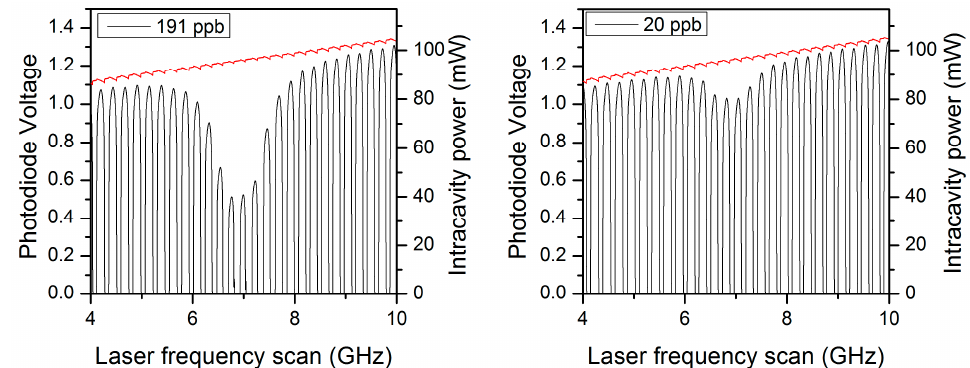
Figure 5. Zoom in the photodiodes signals recorded during the laser spectral scan around the NO absorption lines for two concentrations (at 107 mbar). The photodiode signals (in black) allows for monitoring the cavity transmission and to derive the intra-cavity power (right axis). Note that a small incident laser power change induced by the optical feedback (OF) is observed in the reference signal (in red).